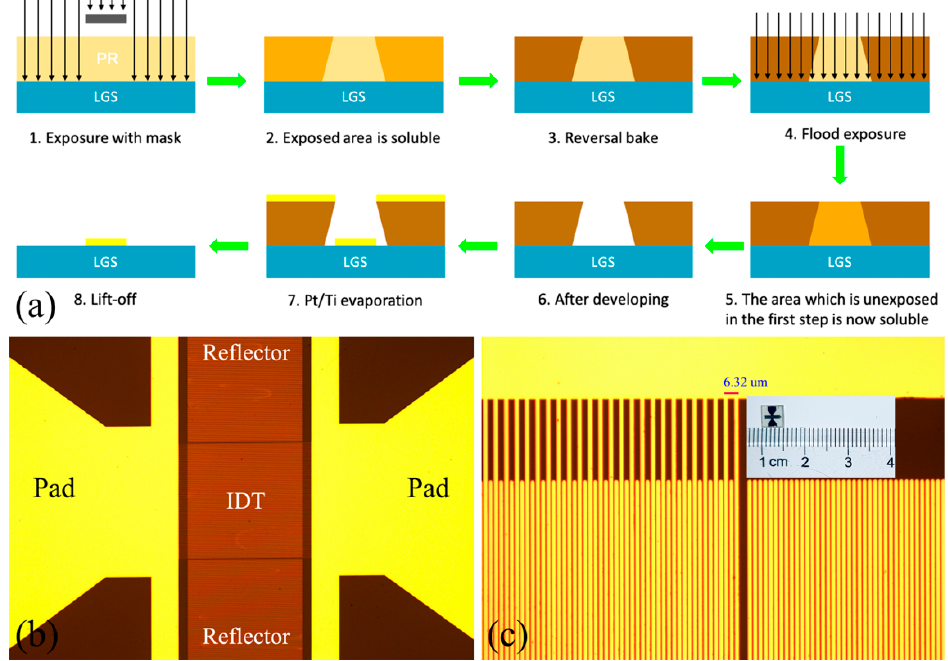
Figure 1. Fabrication steps for the Pt / LGS SAW device ( a ) A micrograph which shows the layout of the device; ( b ) Microscope image of the patterned Pt electrode with a periodicity of 6.32 μ m, and the inset is an optical photo of the fabricated device ( c ).